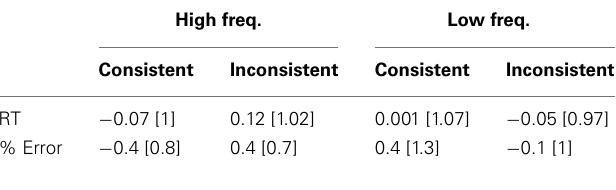
Table 4 | Mean standardized RTs for correct responses and error rates (SD in brackets) observed on word stimuli in the noise condition. High